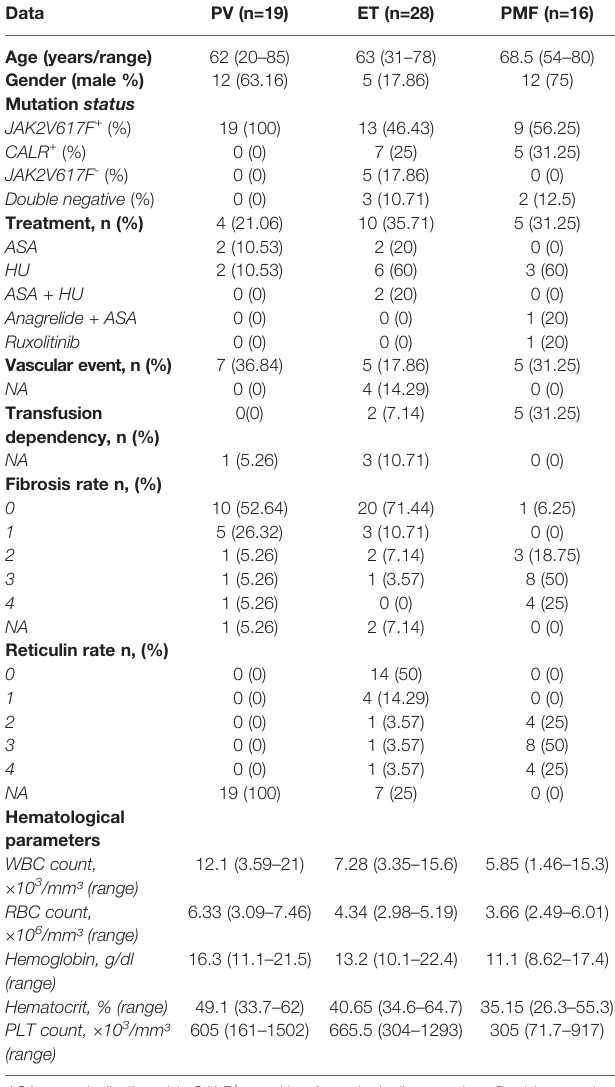
TABLE 1 | Demographic data and clinic-laboratory parameters from polycythemia vera (PV), essential thrombocythemia (ET), and primary myelo fi brosis (PMF)